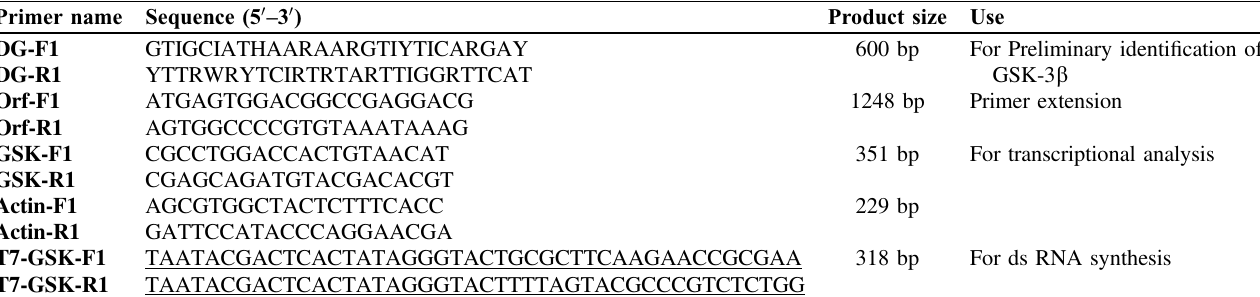
Table 1. List of Primer used in this experiment.